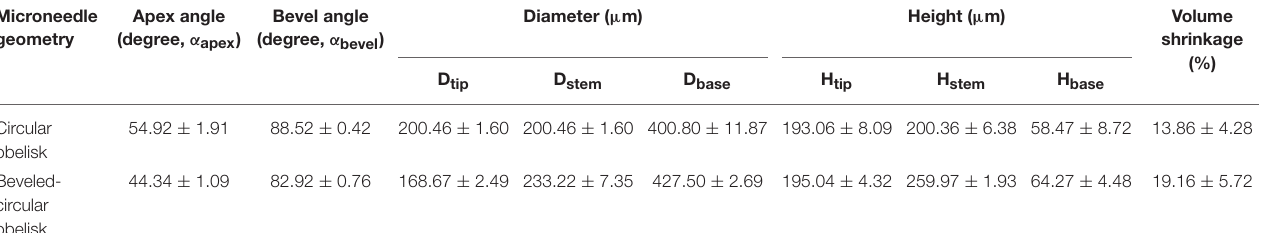
TABLE 4 | Measured dimensions of PLGA microneedles (mean ± standard deviation, n = 7). Microneedle geometry